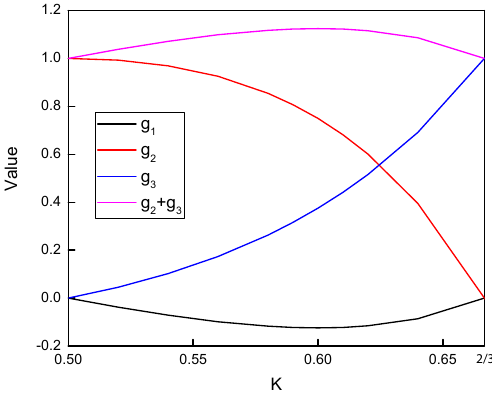
Figure 1. Comparison between the factors in the Taylor series ex- pansion of F(γ) as a function of the Van der Burgh coefficient K